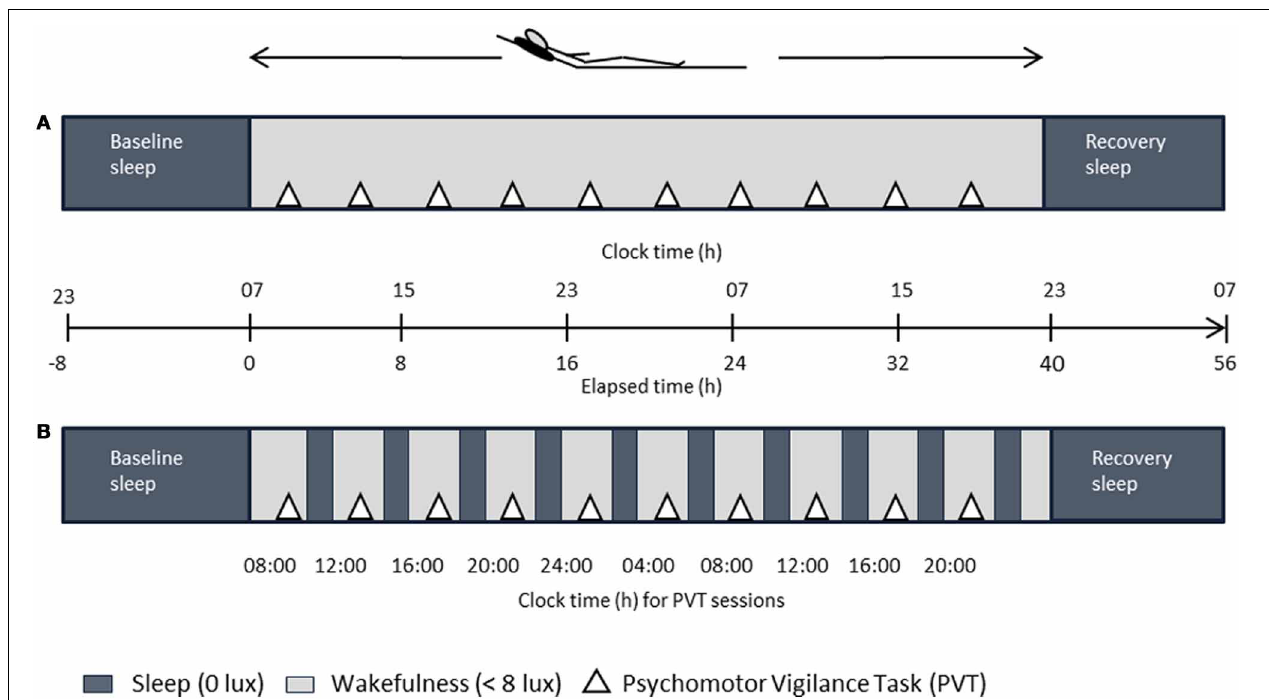
FIGURE 1 | Overview of the laboratory part. After baseline sleep (8 h), either a 40-h sleep deprivation (A) or a 40-h multiple nap paradigm ( B , ten 80/160-min sleep/wake cycles) under controlled posture conditions was